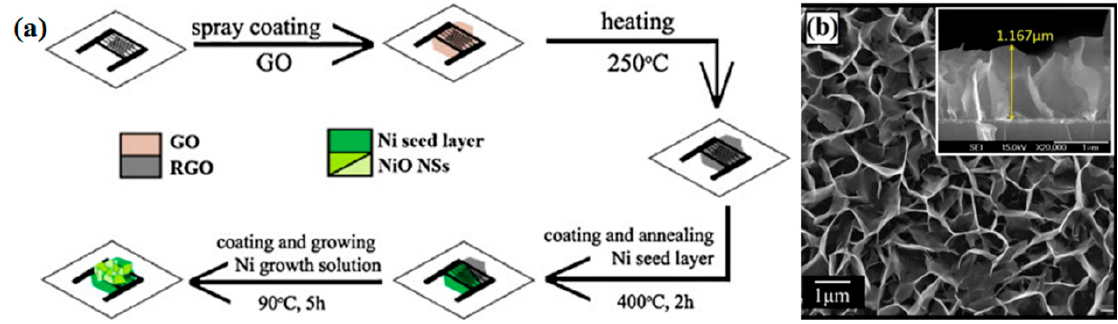
Figure 5. ( a ) Schematic illustration of formation of 3D porous rGO/NiO nanosheets hybrids; ( b ) SEM pictures of samples. Reproduced with permission from [71], © 2013 Elsevier.